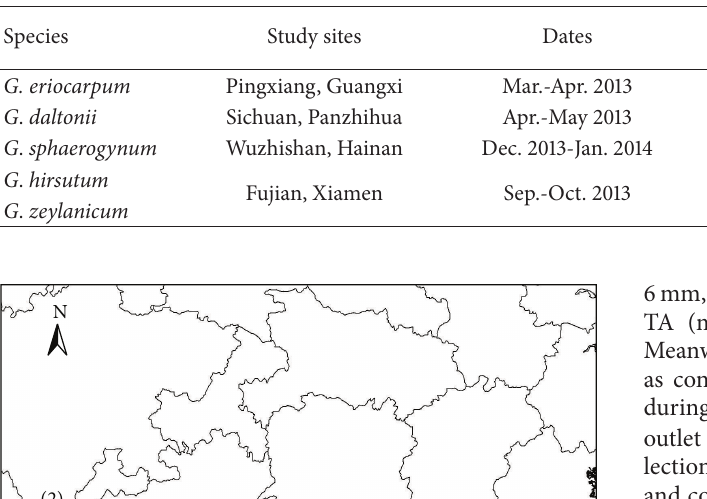
Table 1: Study sites, dates, and sample sizes of five Glochidion species headspace collections.